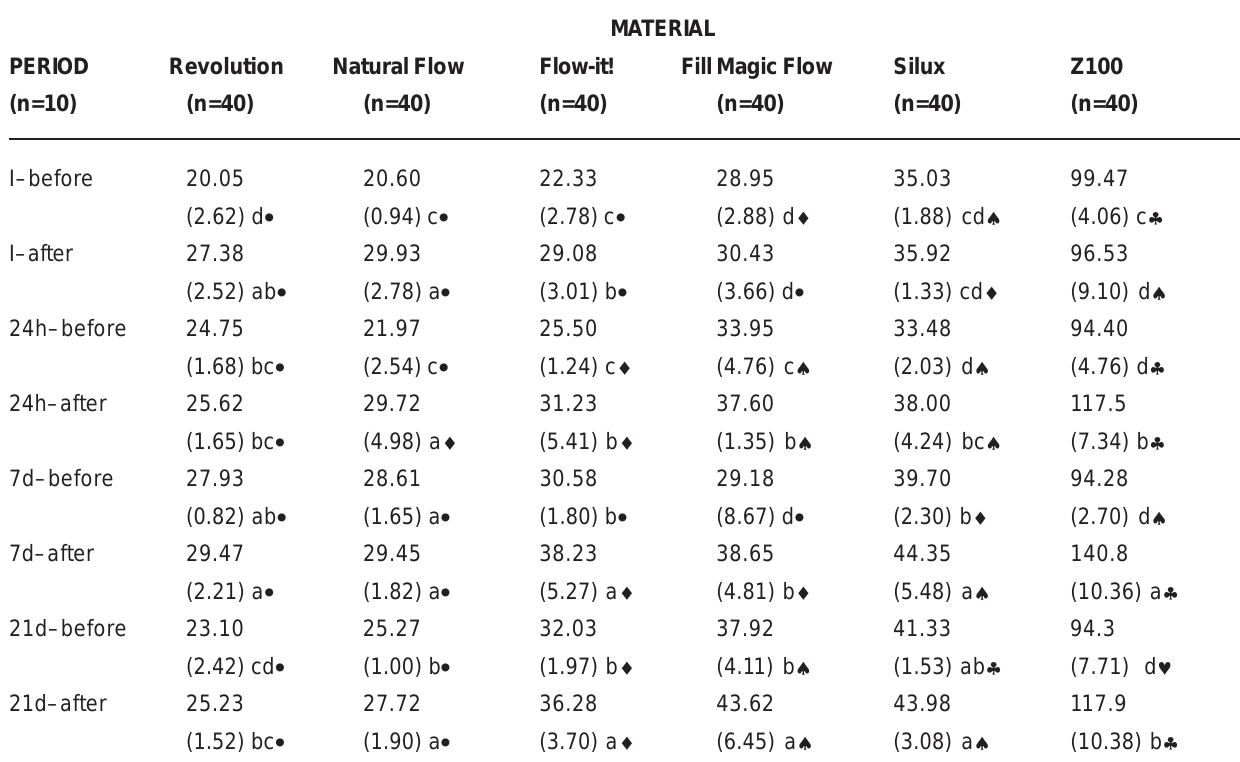
Same letters: statistical similarity - comparison in